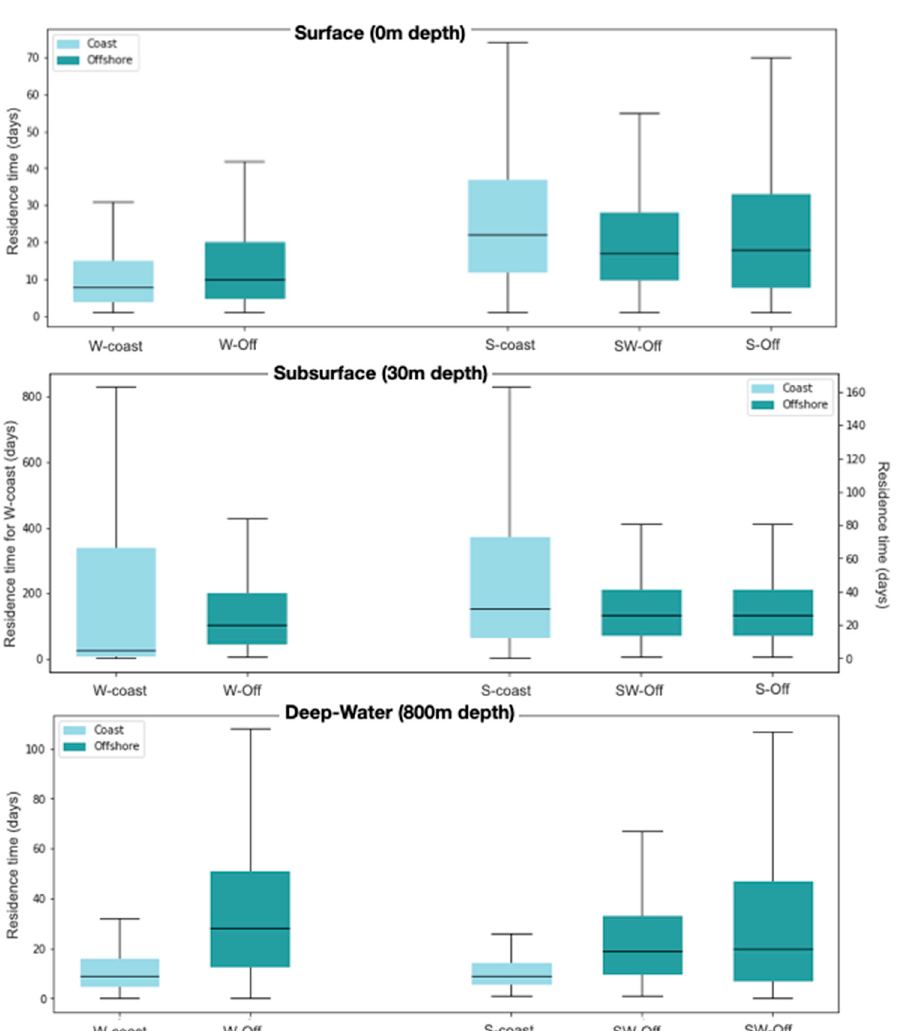
Figure 5. Residence time (in days) of particles calculated for each of the five sub-regions according to Figure 2b (W-coast, W-Off, S-coast, SW-Off, and S-Off) for the simulations at the surface (top box), subsurface (middle box) and deep-water (bottom box) levels. Note the different axis scales.